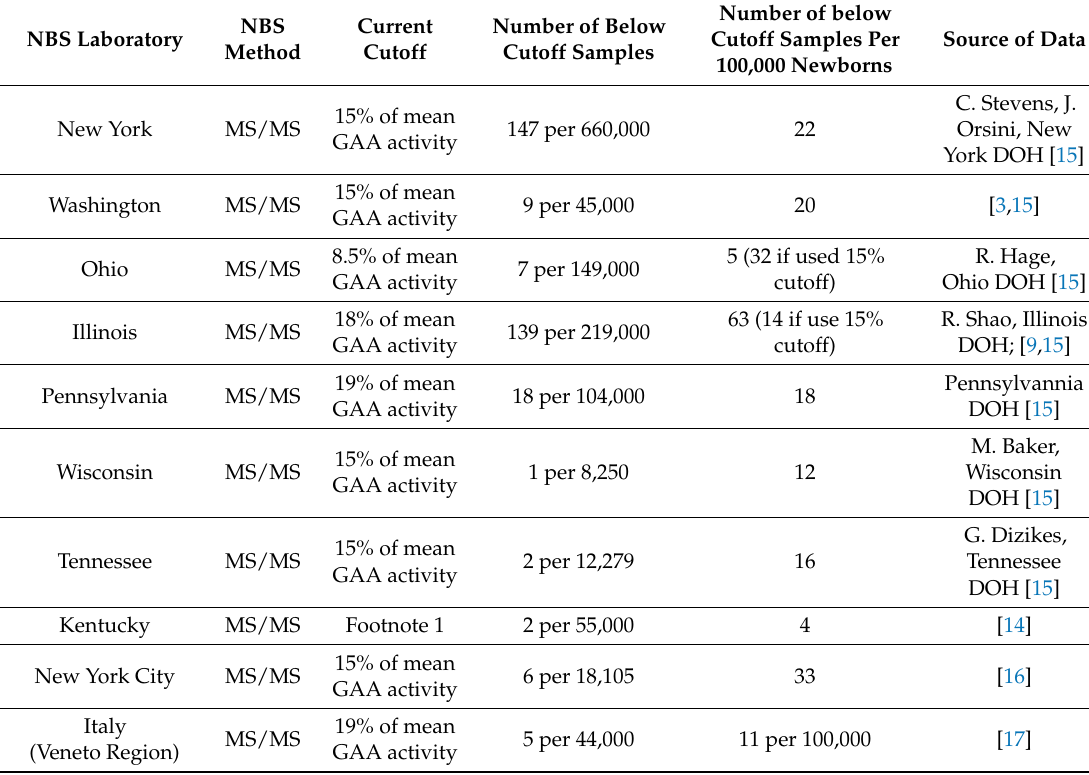
Table 2. NBS laboratory screen positive rates for Pompe disease.